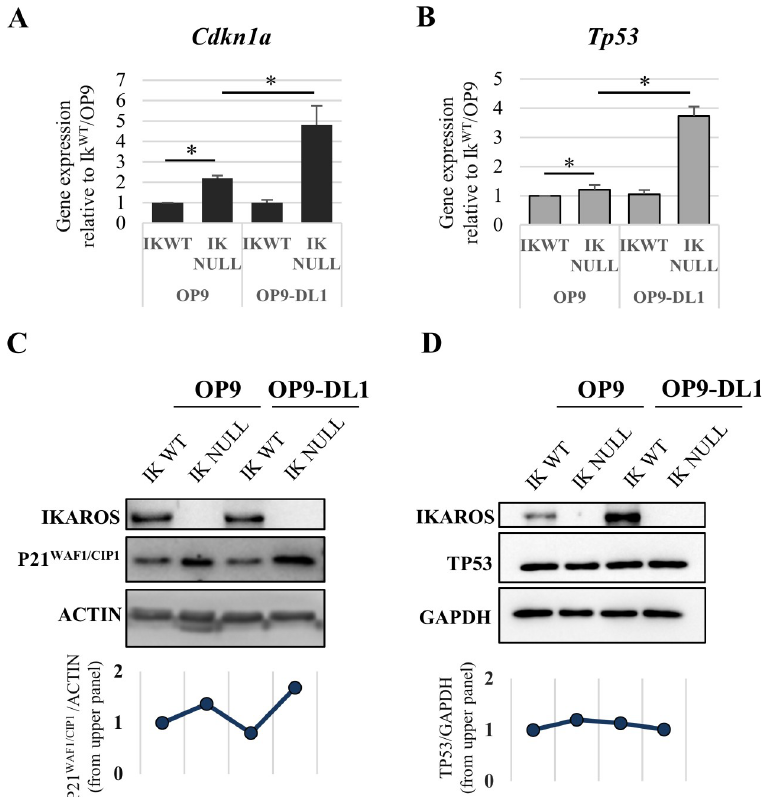
Fig 4. Cdkn1a and Tp53 gene and protein expression in Ik WT and Ik Null Ter119 + cells upon NOTCH induction. (A, B) Gene expression; the relative expression levels of Cdkn1a and Tp53 genes in Ik WT and Ik Null Ter119 + cells before (OP9 co-culture) or after (OP9-DL1 co-culture) NOTCH induction, were measured by qRT-PCR, calculated according to the Pfaffl equation using Hprt as internal control and normalized to Ik WT /OP9; y axis: relative RNA enrichment levels, ratios are represented by bars and are plotted as the mean ± Standard Deviation (SD) of the measurements; data shown are the results of five independent experiments; � : p � 0.05 by Student’s t -test. (C, D) Western blot analysis of IKAROS (65 KDa), P21 WAF1/CIP1 (21 KDa), TP53 (53 KDa) and ACTIN (42 KDa) or GAPDH (38 KDa) [used as loading controls] expression in Ik WT and Ik Null Ter119 + cells before (OP9 co-culture) or after (OP9-DL1 co-culture) NOTCH induction; dot graphs: relative quantification of P21 WAF1/CIP1 (panel C; also refer to S5 Fig) or TP53 (panel D) proteins relative to ACTIN or GAPDH, respectively.